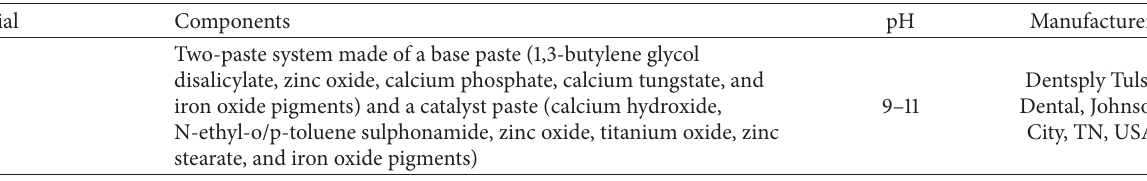
Table 1: Characteristics of tested